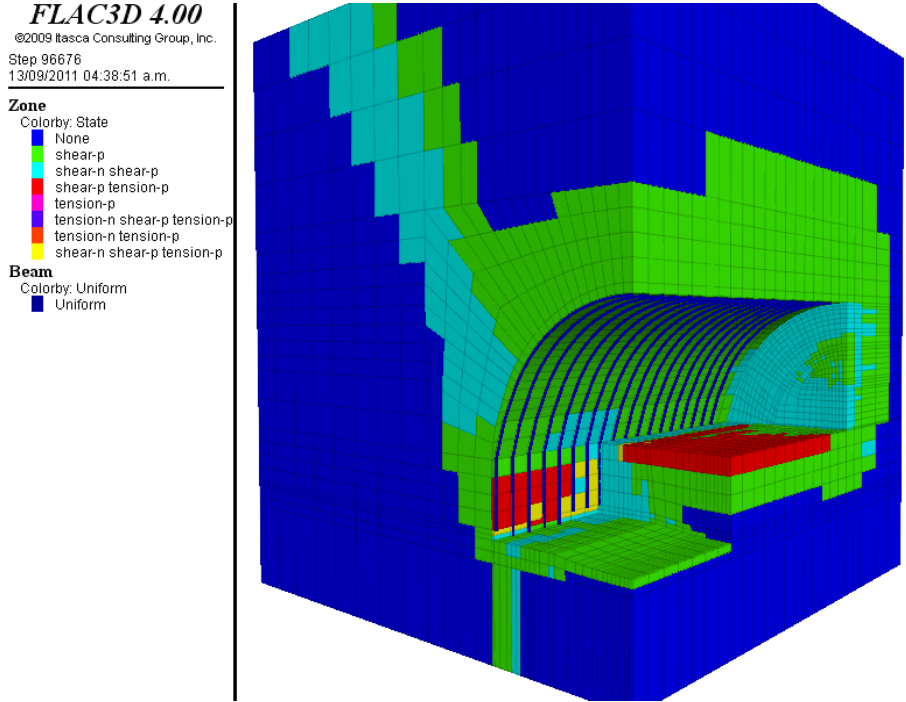
Figure 31. States of plasticization in an intermediate stage of the excavation. Minimum parame ‐ ters.